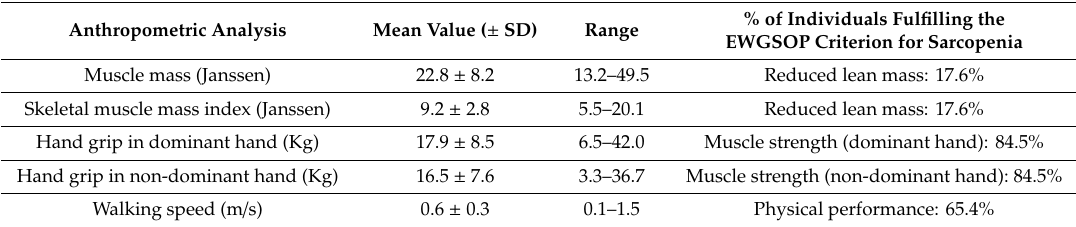
Table 3. Anthropometric analysis and sarcopenia parameters.